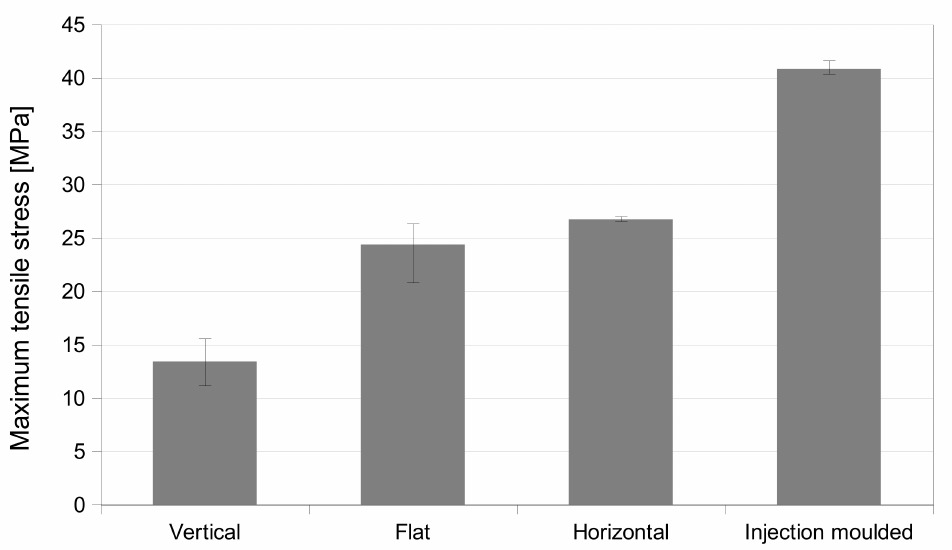
Figure 6. The influence of the orientation of printing on the mechanical properties of the samples. The influence of the infill density of printed samples was also analyzed (Figure 7). A comparison is presented for the same printing parameters as previously prepared for the 1A test samples printed in “flat” orientation. The infill pattern for individual samples is presented in Figure 2. Once again, for comparison, the results of the injection molded parts are denoted.